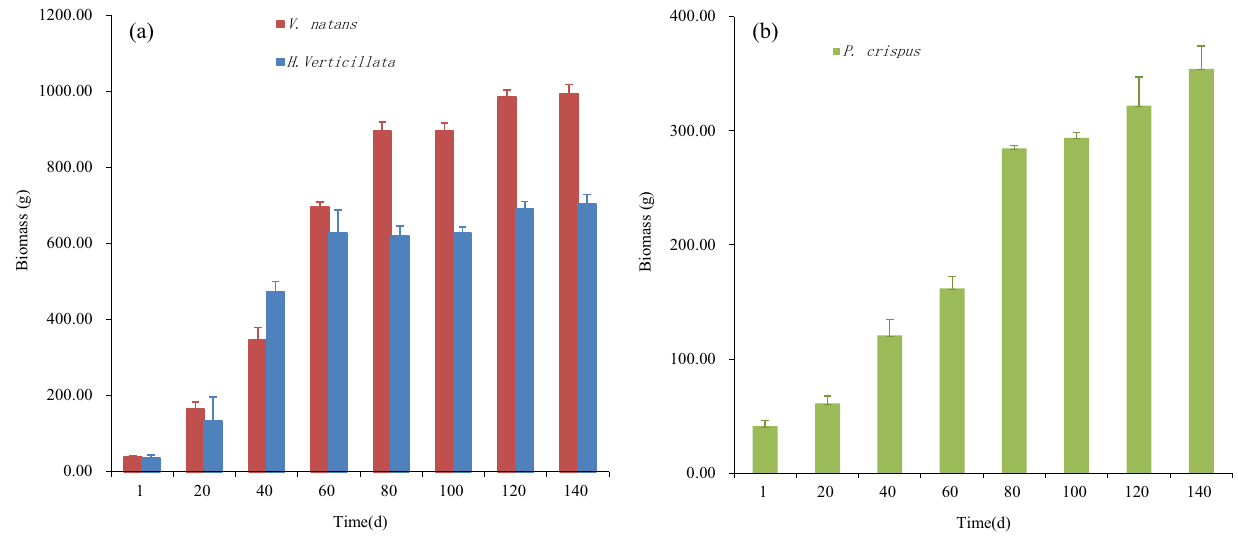
Fig. 2 Biomass of H. verticillata, V. natans, and P. crispus . The results are the mean ± standard